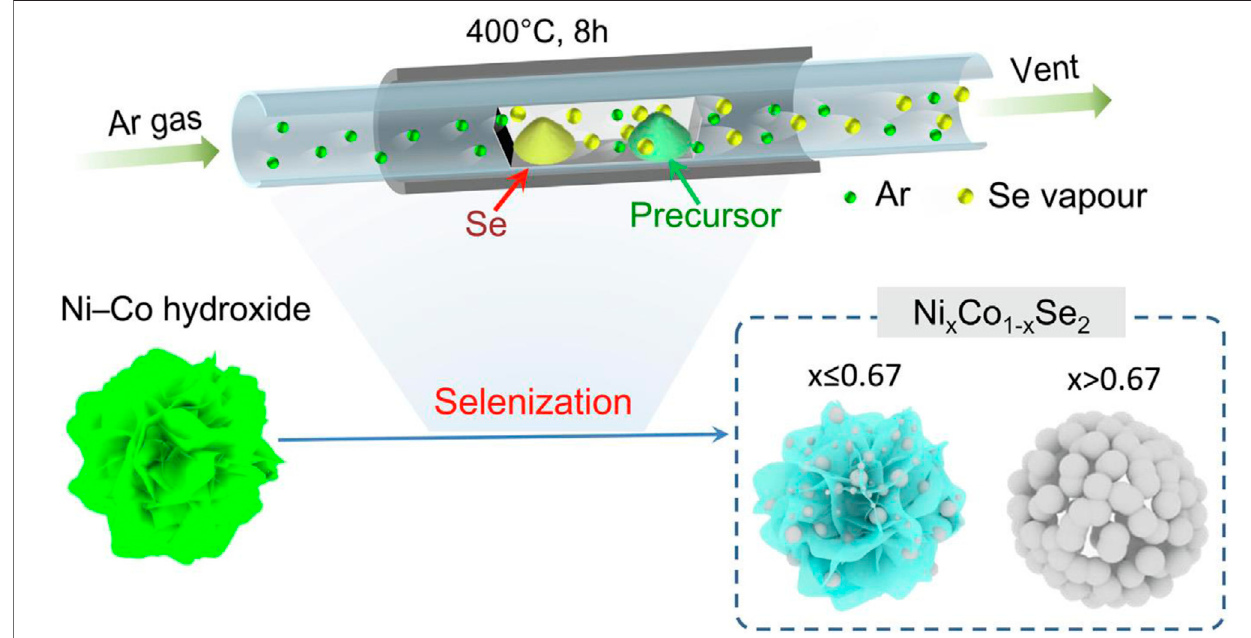
FIGURE 5 | schematic diagram of typical thermal decomposition synthesis method.